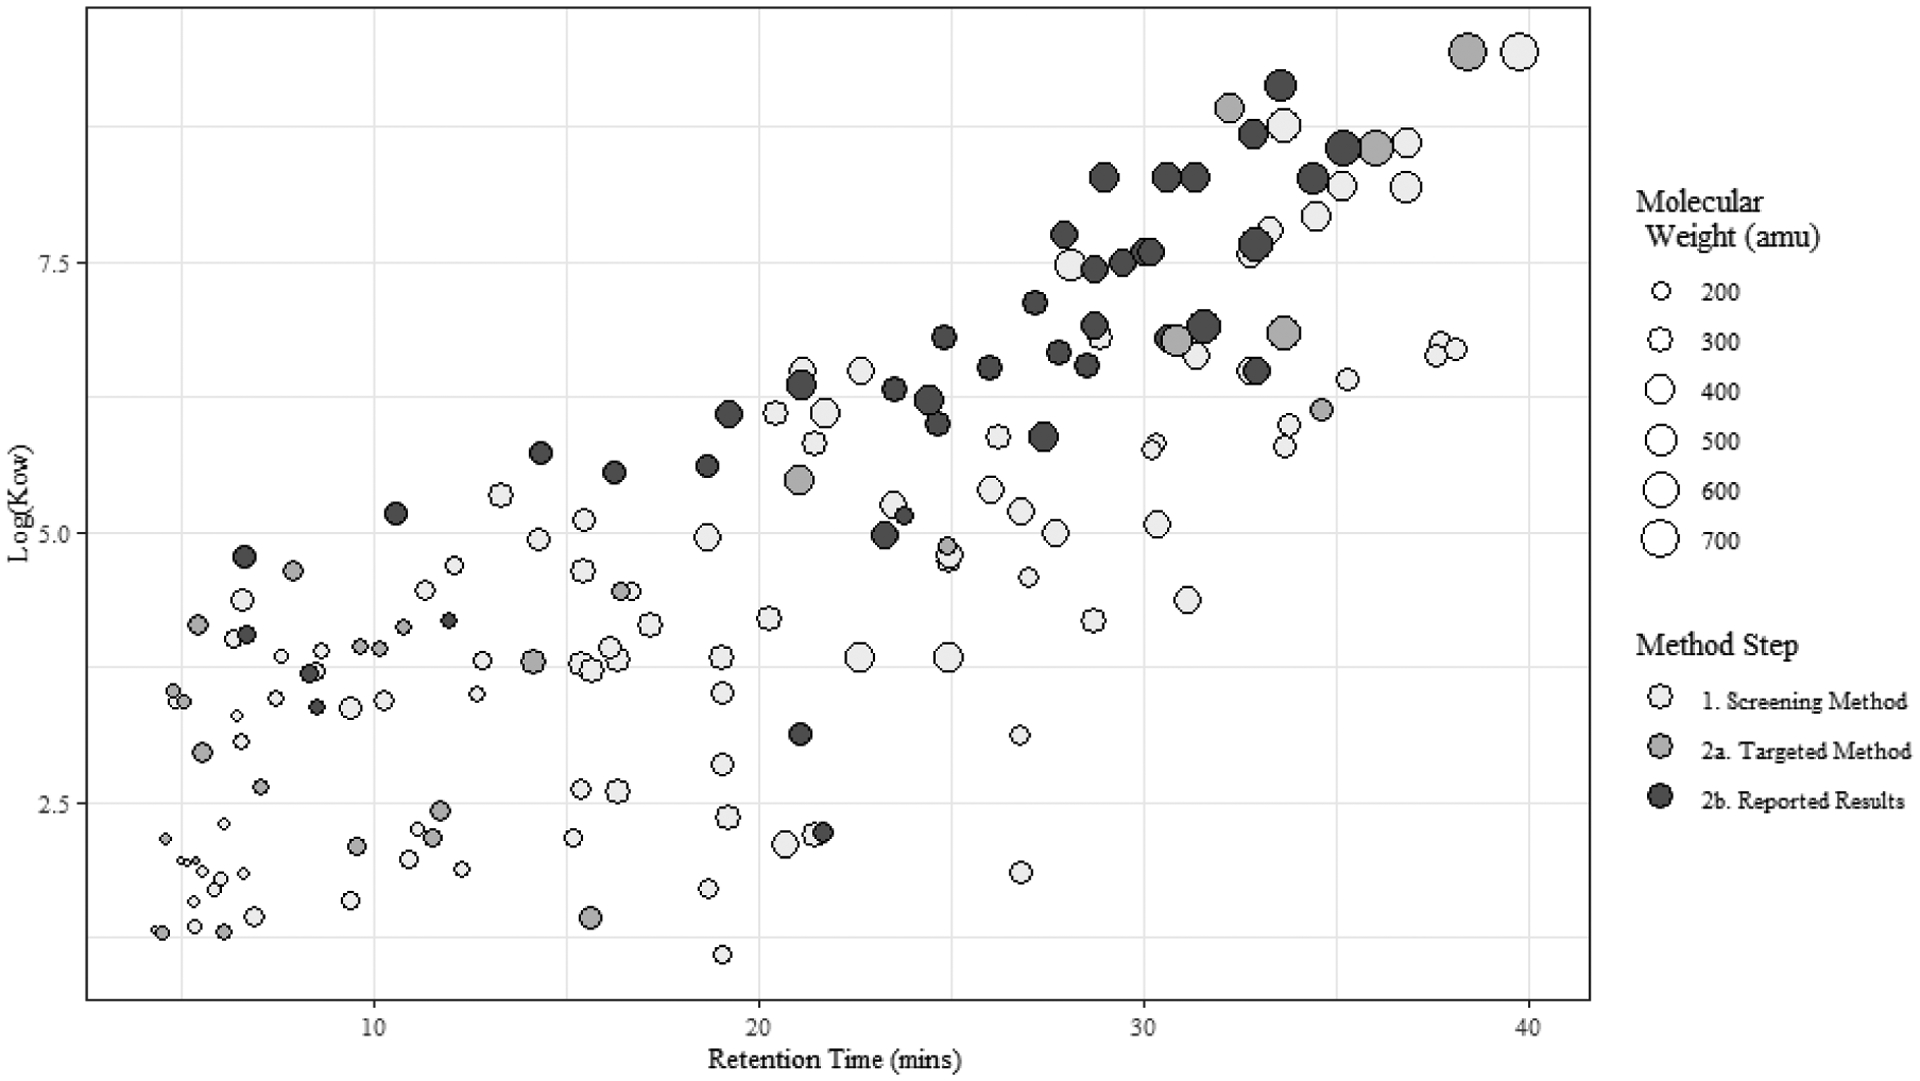
Chemicals included in each stage of the method where Log(Kow) is the logarithm of the octanol-water partition coefficient, and retention time is an indicator of compound volatility. Dot size indicates molecular weight of the chemical, where each dot represents a chemical that was included in the screening method. Dots are shaded to indicate whether the chemical was eliminated from study after the screening method (no shading), eliminated from study after the targeted method (grey shading), or not eliminated (i.e. final results were reported; black shading)